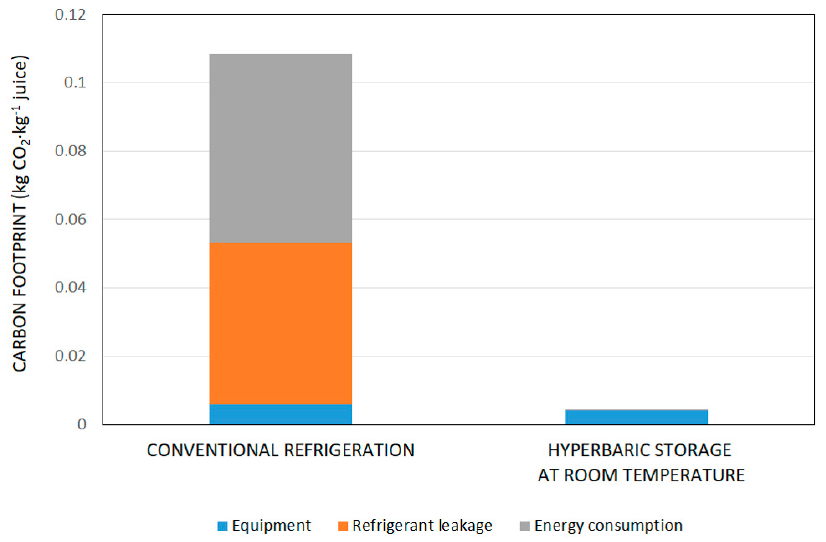
Figure 2. Contribution of different sources to CO 2 emissions in conventional refrigeration and hyperbaric storage at room temperature.